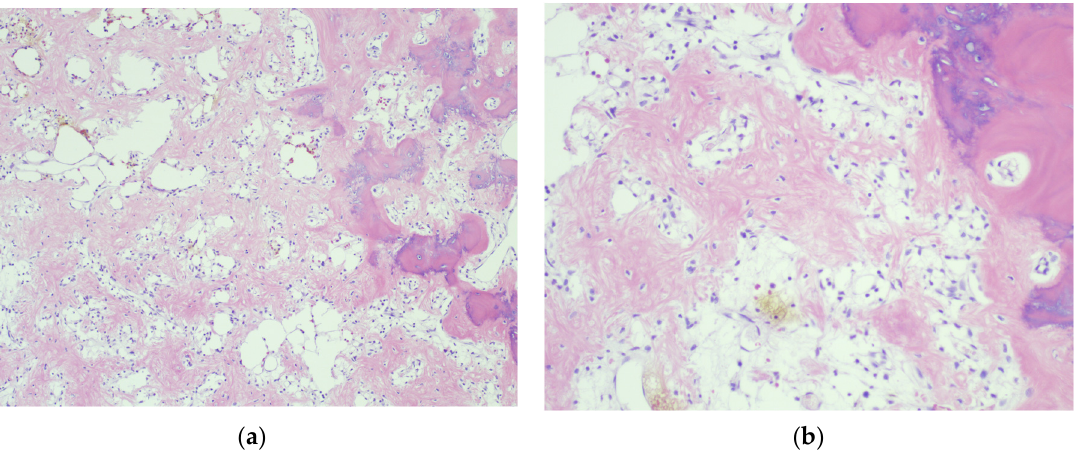
Figure 5. ( a ) Low magnification histologic examination of GCT of L5 vertebral body after 6 months of IV denosumab therapy shows increased ossification. ( b ) Mid-level magnification histologic examination of a GCT of L5 vertebral body shows decreased number of multinucleated giant cells with increased ossification and fibrosis.